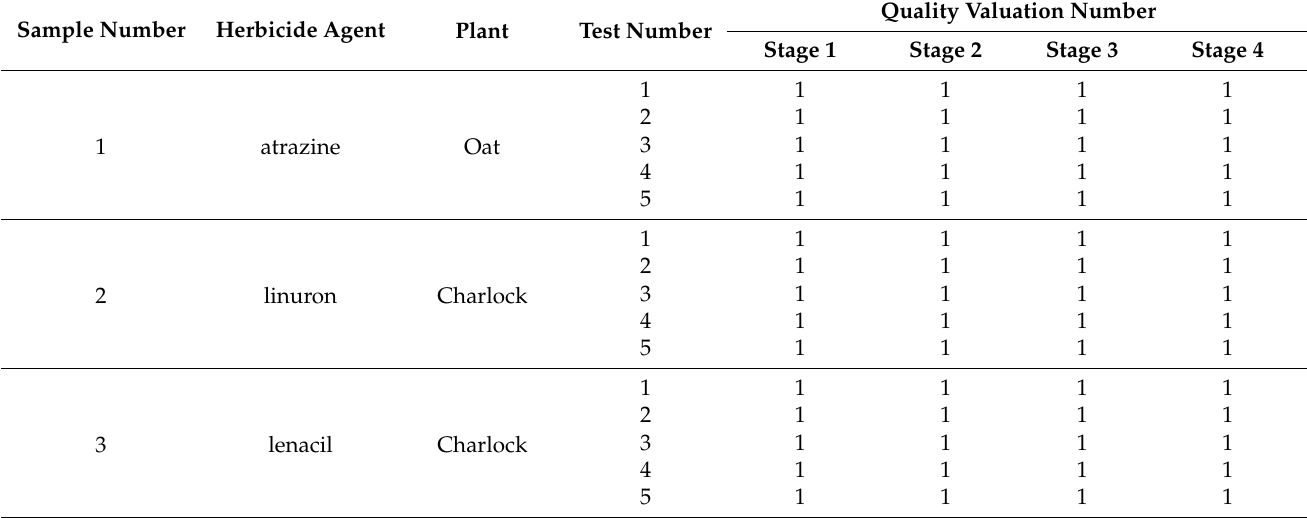
Table 6. Results of the 2nd series of biological